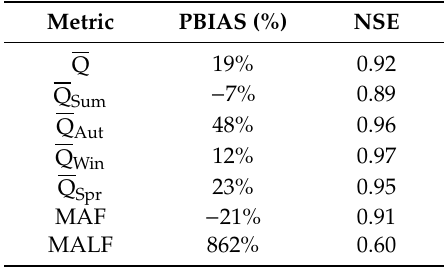
Figure 2. Scatter plot of modelled vs. observed values of the seven flow descriptors: mean flow (Q), mean summer, autumn, winter, and spring flows (Q Sum , Q Aut , Q Win , Q Spr ), Mean Annual Flood (MAF), and Mean Annual 7-day Low Flow (MALF). Table 1. National PBIAS and NSE for the seven flow